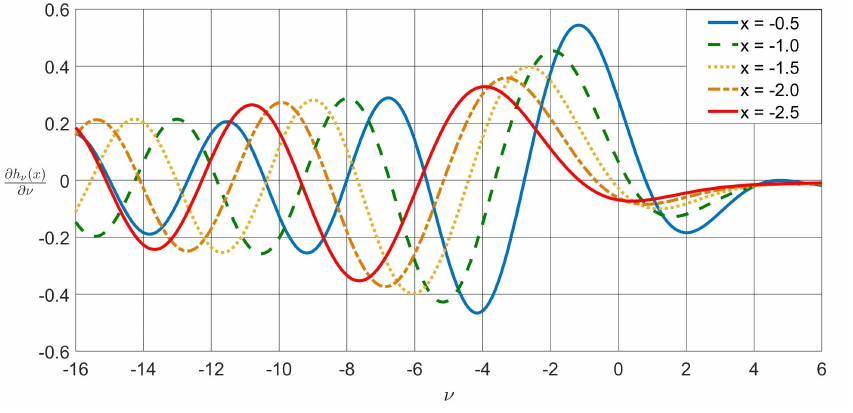
Figure 12. First derivatives of the Havelock functions with respect to the order at fixed negative values of argument x